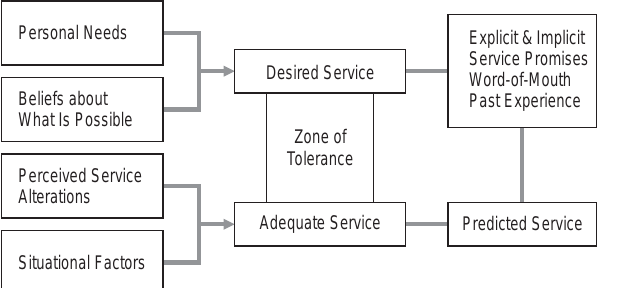
Fig. 5. Customer perceptions of service quality and customer satisfaction